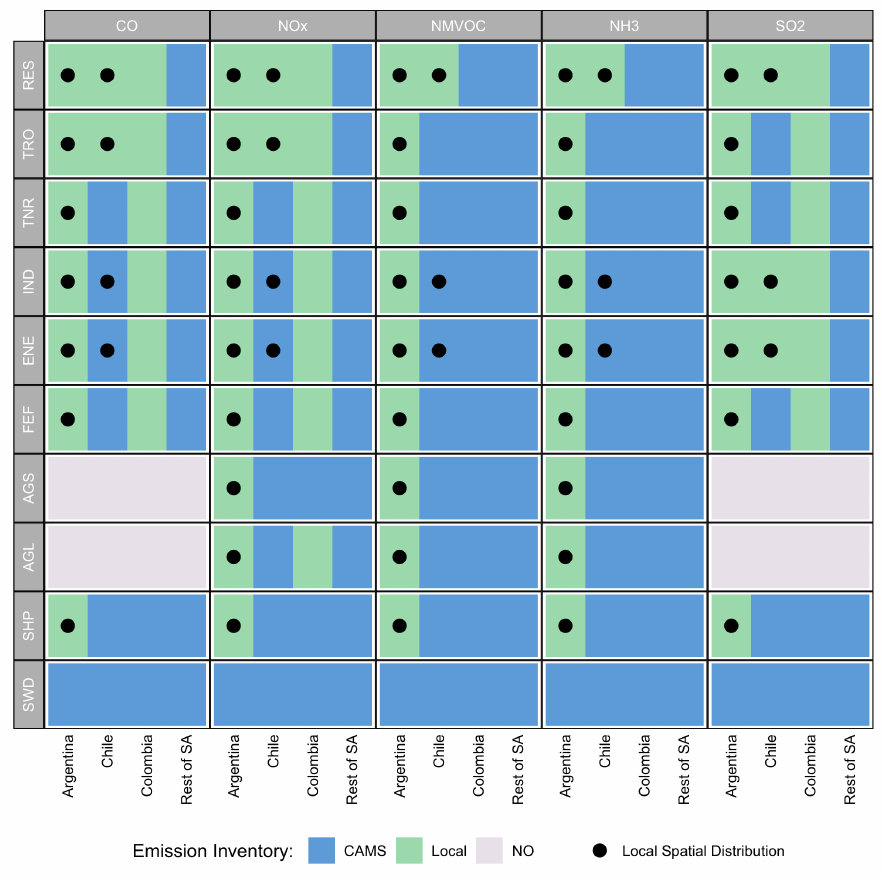
Figure 1. Local and global information on emissions and their spatial disaggregation included in the PAPILA dataset, by species, category, and country. ENE: thermal power plants; RES: residential, commercial, and other combustion; TR: road transportation; TRN: non-road transportation; FEF: fugitive emissions; IND: industrial process; AGS: agricultural soils; AGL: agriculture livestock; SHP: domestic and international navigation; SWD: waste. CAMS refers to the global dataset CAMS-GLOB-ANT v4.1, and “Rest of SA” refers to the rest of the countries of the South American region. NO: not